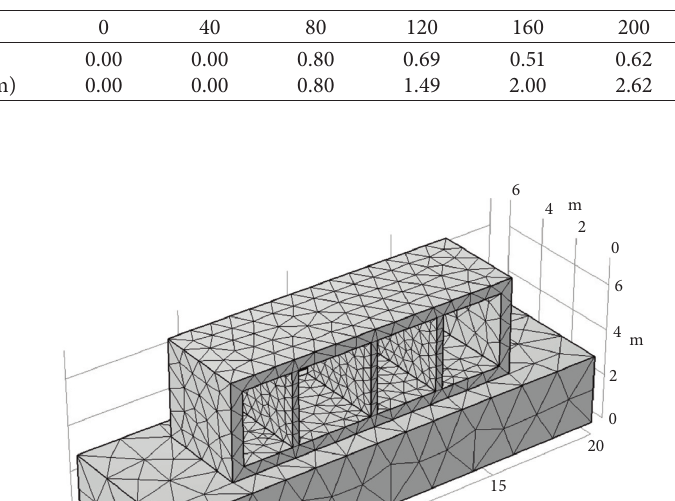
Table 3: Load settlement data curve.